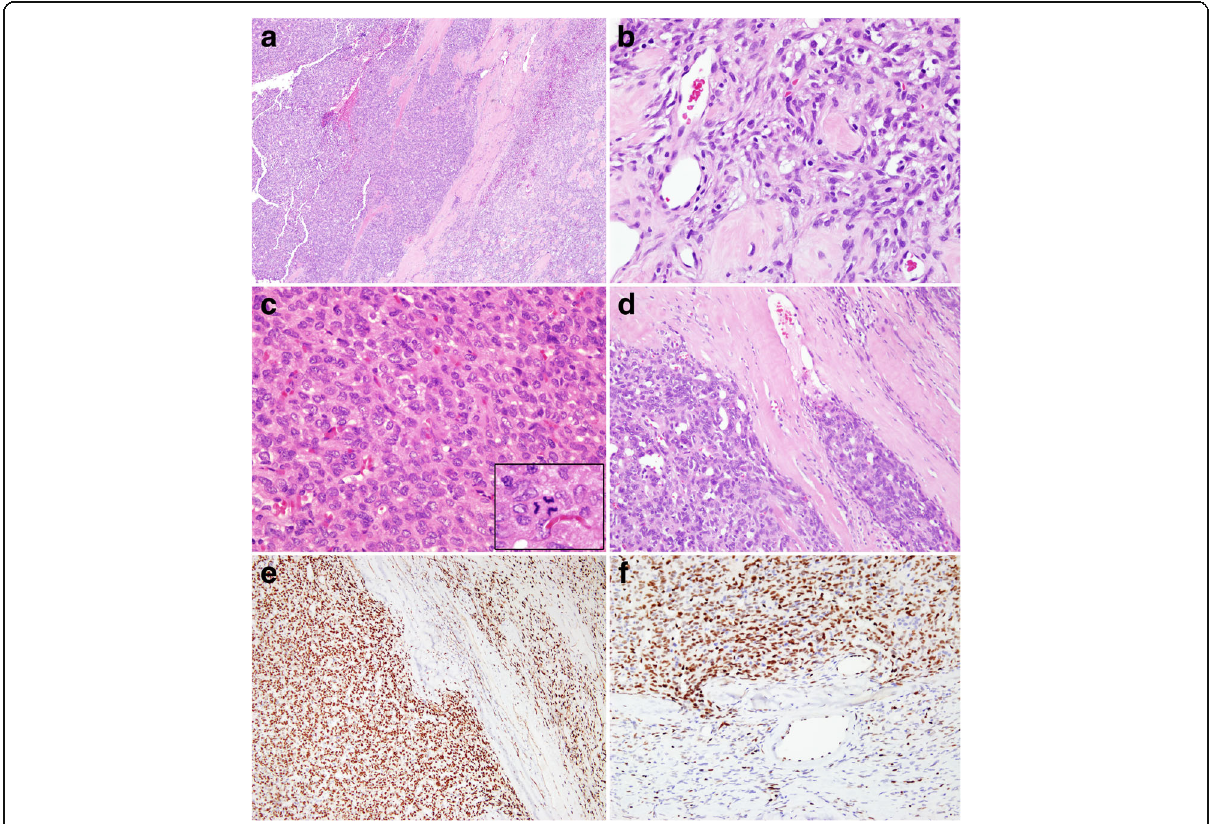
Fig. 2 a Dedifferetiaetd component (left) separated by fibrous septa, with abrupt transition to conventional solitary fibrous tumor (right) (Haematoxylin and eosin stain, 100x). b Low-grade area showing spindle cell morphology with sclerotic stroma (Haematoxylin and eosin stain, 400x). c Dedifferentiated area exhibiting poorly differentiated epithelioid morphology. Inset shows atypical mitotic figure (Haematoxylin and eosin stain, 400x). d Angiolymphatic permeation of pleomorphic tumor cells within fibrous septa (Haematoxylin and eosin stain, 400x). e Positive immunohistochemical staining for STAT-6 in both dedifferentiated and convention SFT areas. f Strong nuclear staining of ERG in anaplastic epitheloid cells (upper half); attenuatedor absent expression in peripheral spindle cells (lower